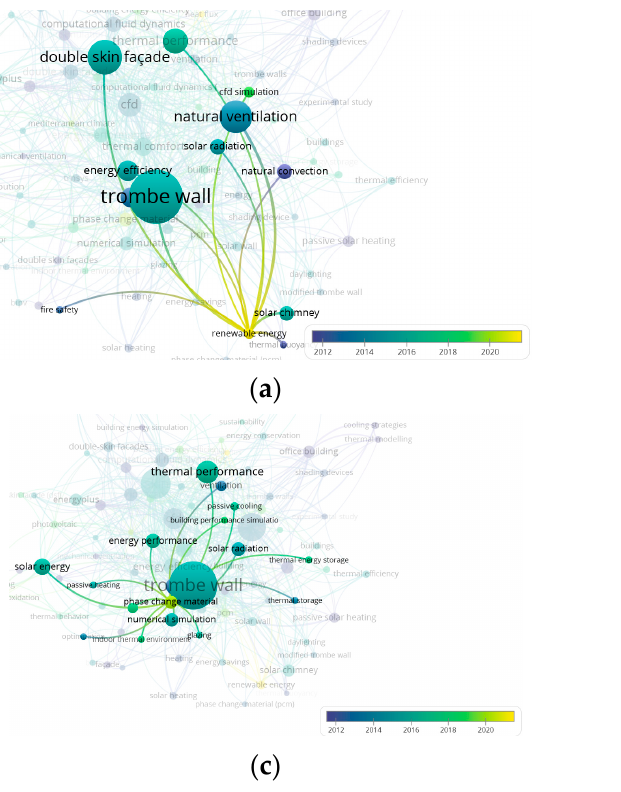
Figure 20. The network map of keyphrases (accessed on 21 January 2022).